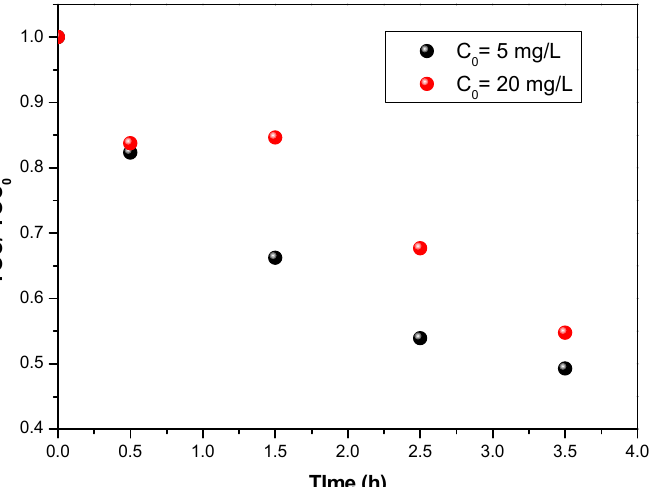
Figure 7. TOC evaluation during flumequine degradation for two initial concentrations for UV 38 W/m 2 and a flow rate of 126 L/h.